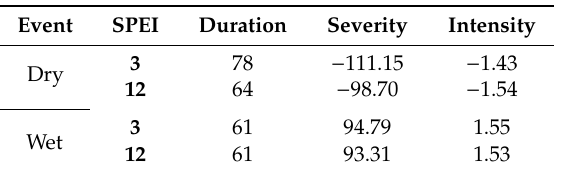
Table 2. The duration, severity, and intensity occurrence of the major dry (SPEI ≤ − 1) and wet (SPEI ≥ 1) events over Kenya during